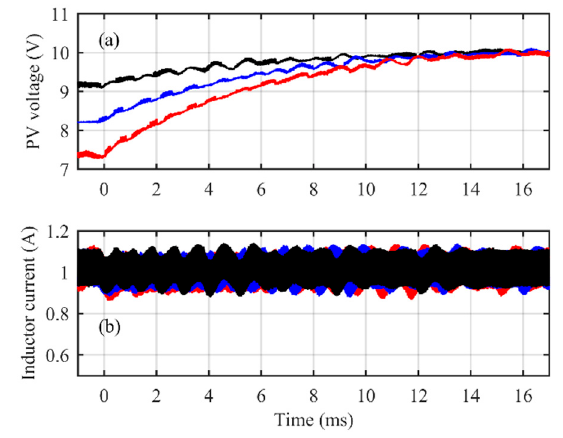
Figure 16. The behavior PVG voltage ( a ) and inductor current ( b ) when the step-changes of 0.9 V (black), 1.8 V (blue), and 2.7 V (red) are applied to the PVG-voltage reference of the interfacing converter under I-type control in CCR.